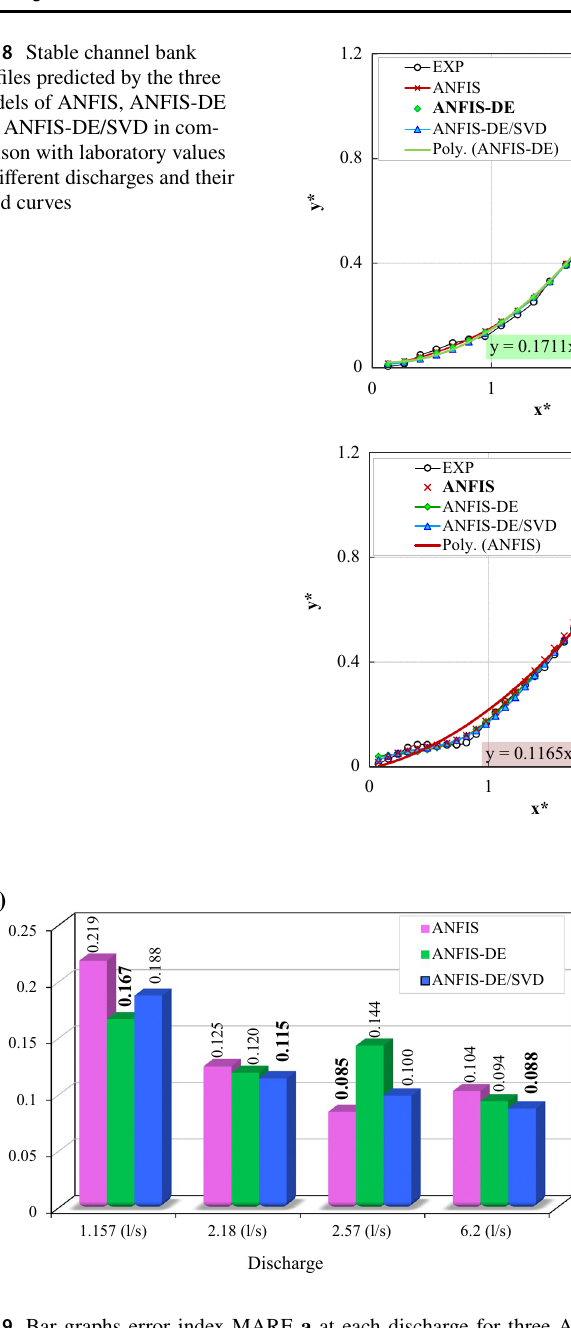
y = 0.1711x 2 - 0.0476x + 0.0258